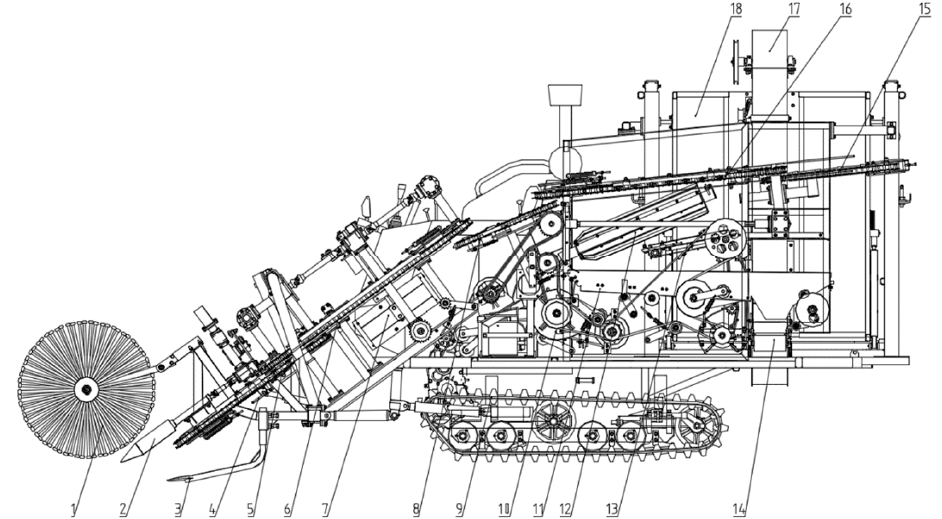
Figure 2. Structural diagram of the 4HLB-4 half-feed four-row peanut combine harvester: 1. Profiling depth-limiting wheel; 2. lifter; 3. excavation shovel; 4. earth-moving rod; 5. left and right clamping and pulling devices; 6. combined conveying device; 7. clap plate; 8. transition clamping and conveying parts; 9. chassis; 10. fan; 11. cleaning sieve; 12. peanut-picking device; 13. scraper conveyor belt; 14. transverse conveyor belt; 15. grass-throwing conveyor chain; 16. peanut-picking conveyor chain; 17. elevator; 18. peanut